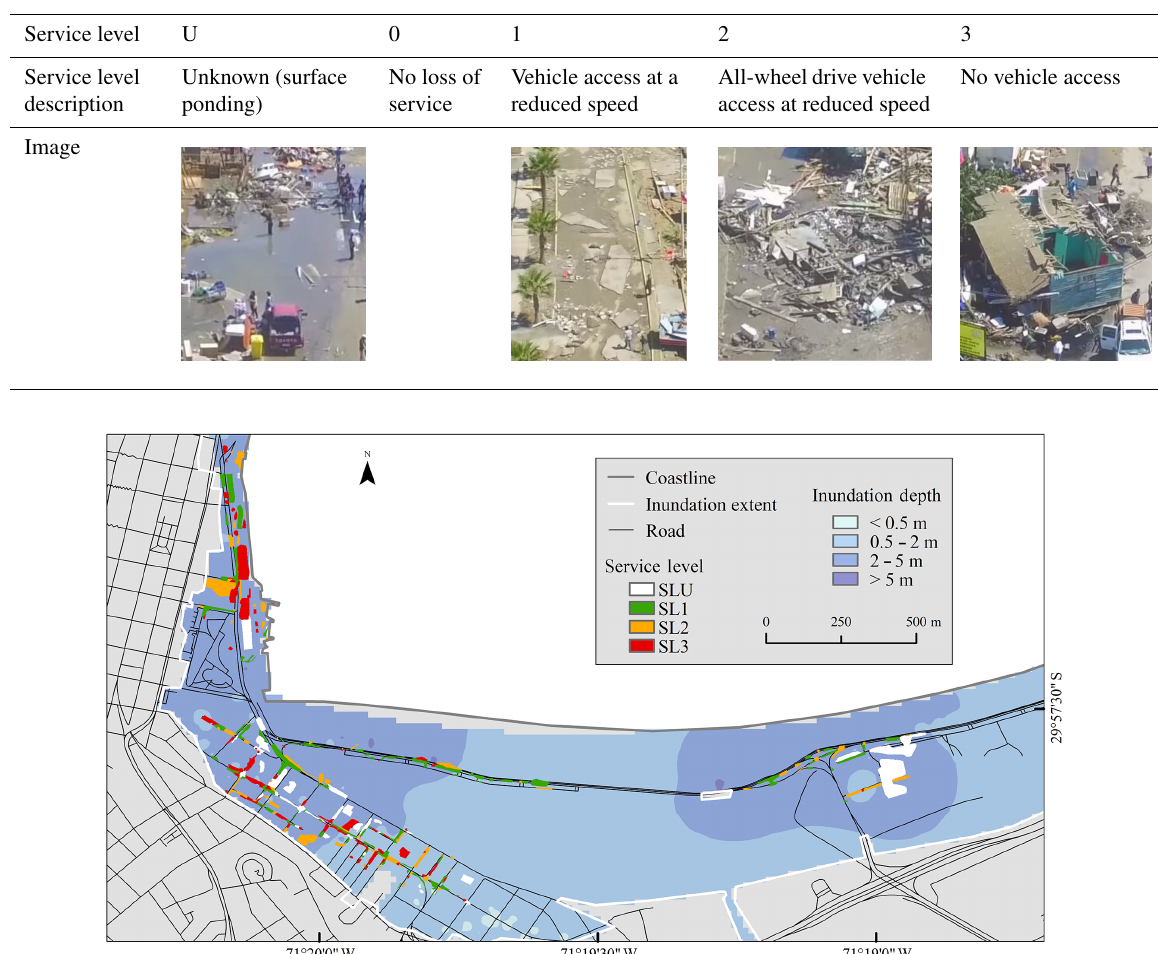
Table 2. Classification schema for road level of service for the 2015 Illapel earthquake and tsunami. Images taken as screenshots sourced from Puerto Creativo (2015).